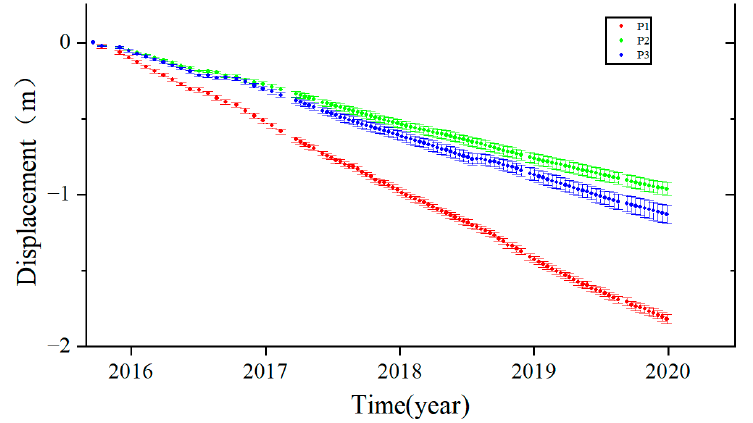
Figure 8. Cumulative deformation map of feature points.